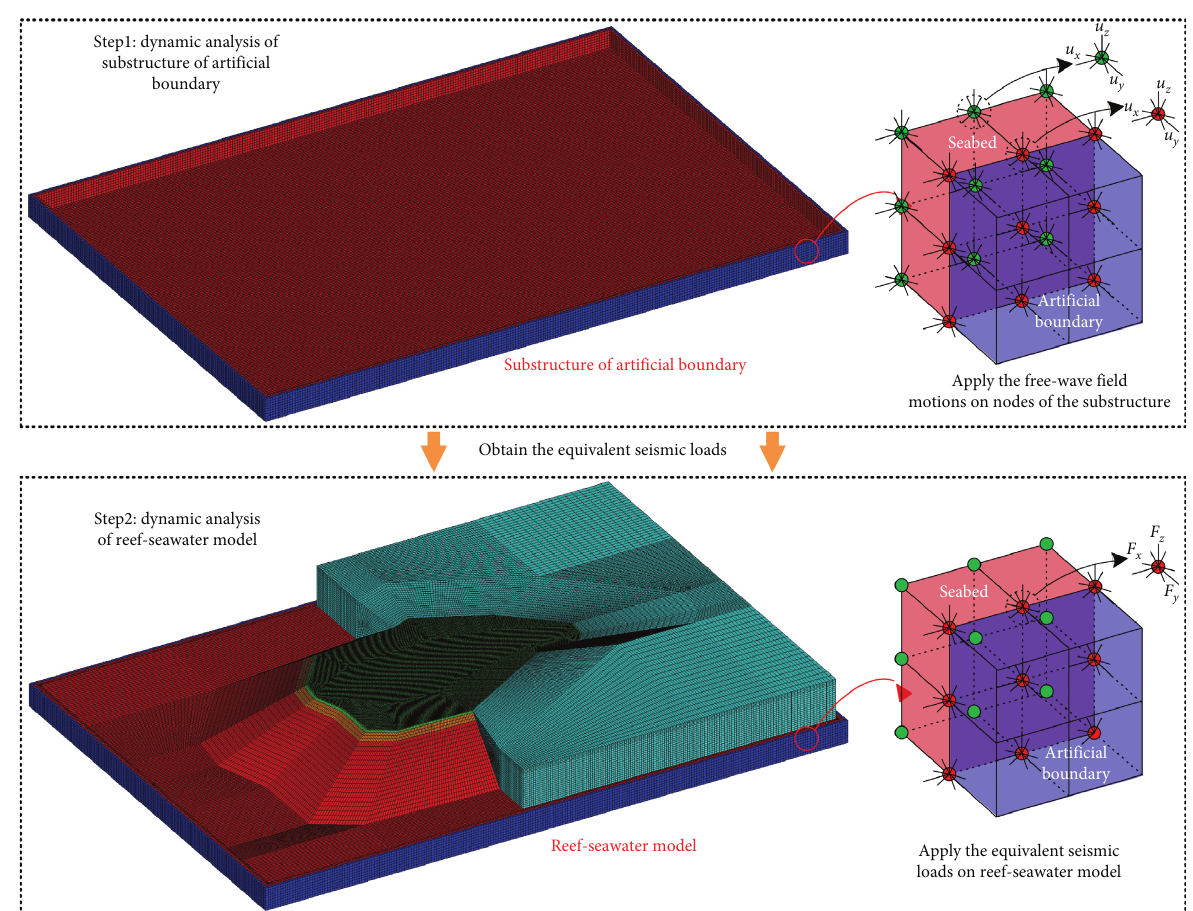
Figure 4: Calculation processes of the seismic wave input method based on substructures of artificial boundaries.